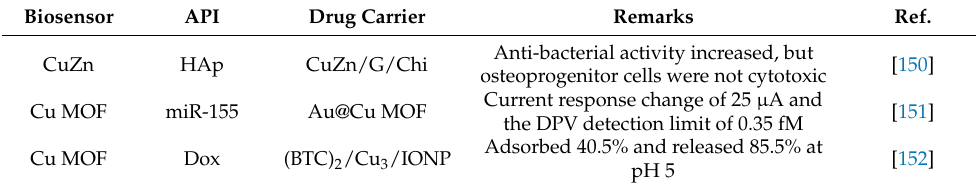
Table 8. Performance of the CuZn and Cu electrical biosensors in drug carriers with remarks.